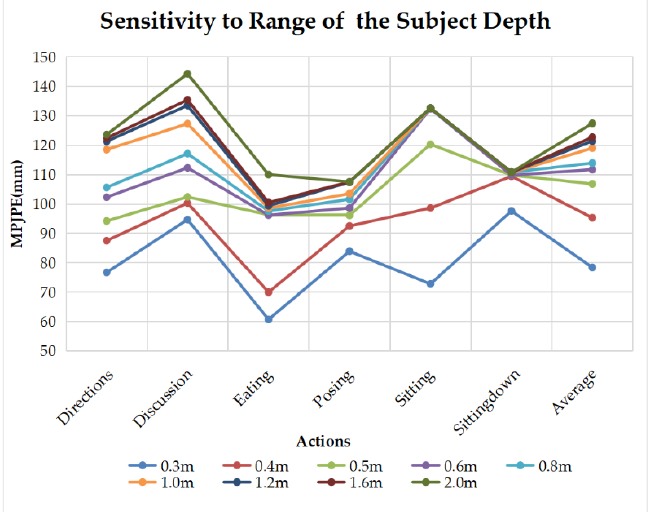
Figure 17. Sensitivity to range of the subject depth.